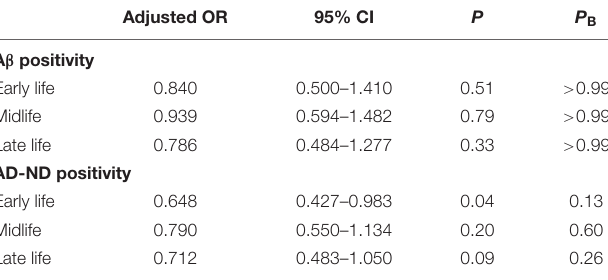
TABLE 3 | Association between cognitive activities in each life period and A β and AD-signature region neurodegeneration (AD-ND) positivity. Adjusted OR 95% CI P P